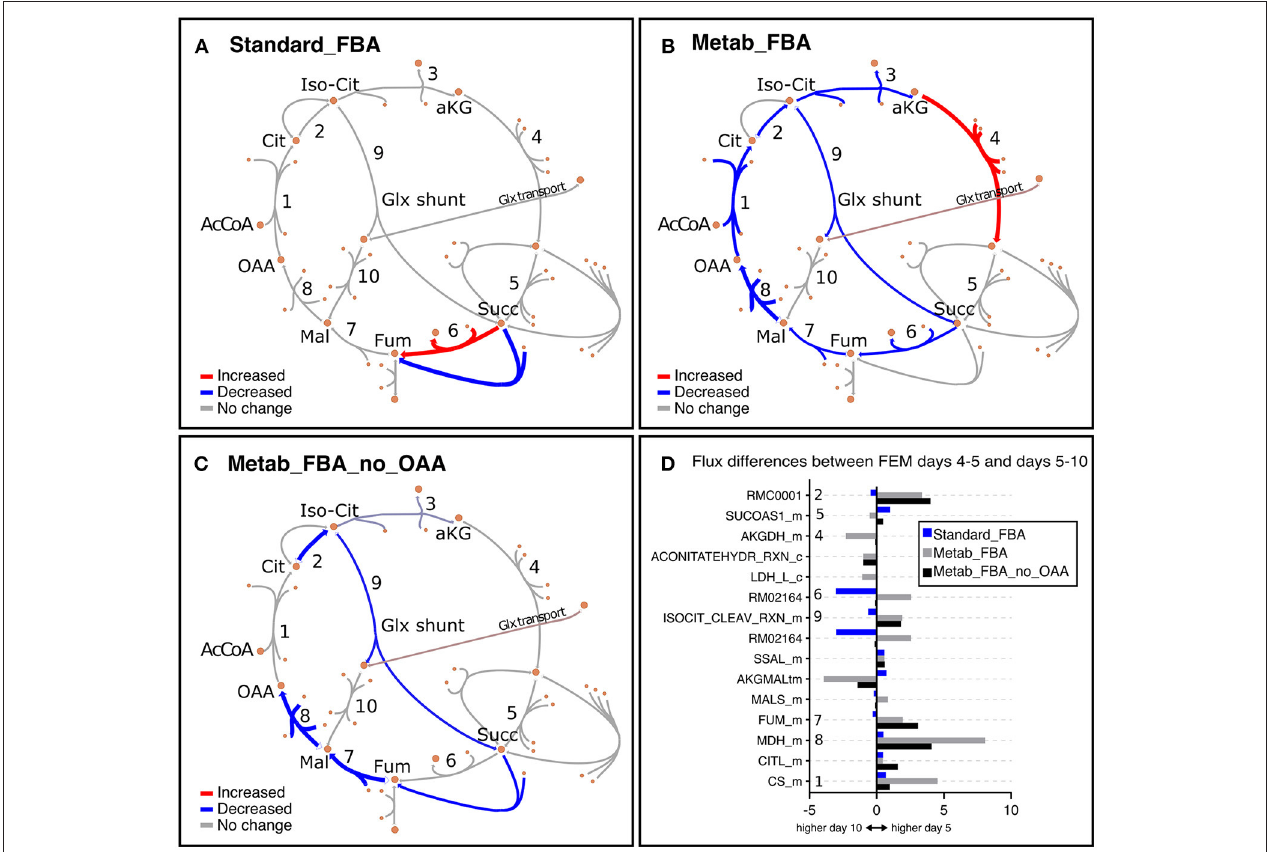
FIGURE 7 | Representation of metabolic fluxes through the TCA cycle in FEM animals using three different objective functions. (A–C) TCA cycle reactions represented with the Escher tool (King et al., 2015) as a comparison between FEM data for the timeframes at days 4–5 (117–137h) and days 5–10 (137–257h) for FBA objective function variants Standard_FBA (A) , Metab_FBA (B) , and Metab_FBA_no_OAA (C) , which does not include (A) or includes information regarding all quantified metabolites (B) or all except oxaloacetate (C) in their respective objective functions. The maps have been colored in Inkscape and colors represent the difference in the fluxes between the two time points, where red is increased and blue is decreased. The weight of the arrows has been adjusted to indicate the magnitude of the change. (D) The differences between the two time frames are illustrated per reaction for each of the three FBA variants. The reaction identifiers from the WormJam model shown in (D) are illustrated in Figure 2A as follows: R_RMC0001: isocitrate hydro-lyase (reaction 1); R_ACONITATEHYDR_RXN_m: aconitase - isocitrate hydrolase (reaction 1a); RMC0001: Cytosolic isocitrate hydrolase (reaction 2) ; AKGDH_m: Mitochondrial 2-oxoglutarate dehydrogenase (reaction 3);